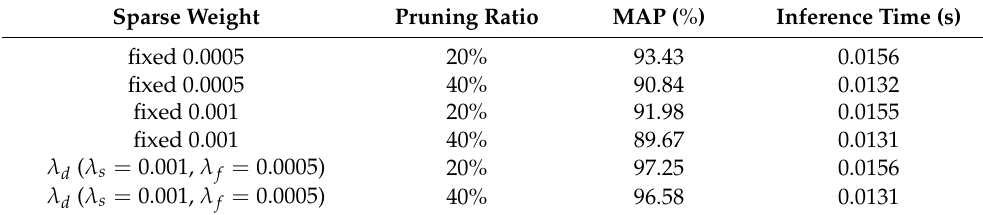
Table 4. Accuracy and speed performance using dynamic and fixed weights.